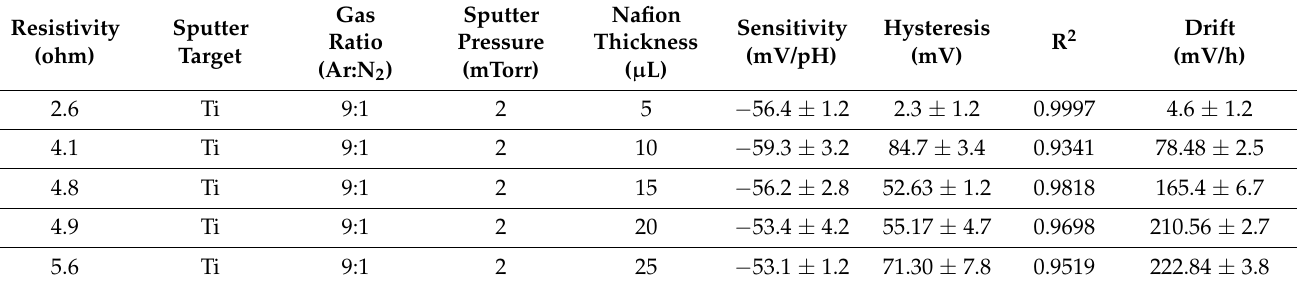
Table 2. Summary of the pH-sensing performance for TiN electrodes with various Nafion thickness ranging from 5 to 25 µ L thickness, with TiN deposited using 2 m Torr pressure and 1:9 Ar: N 2 gas